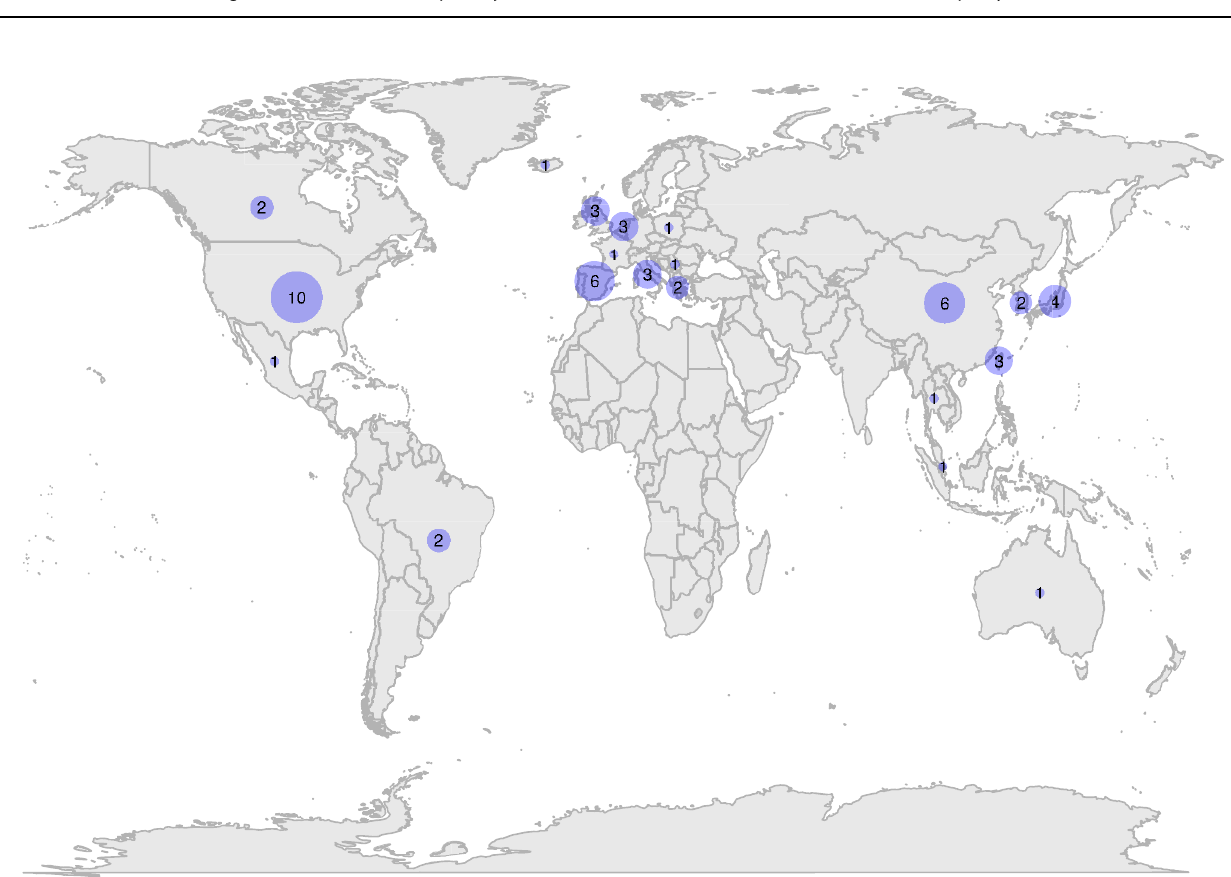
Fig. 2 Map showing the location of the included studies. The numbers on the map indicate the number of included studies from each